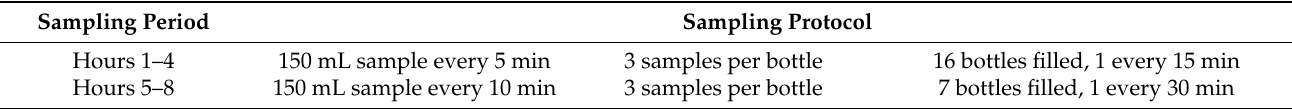
Table 1. Auto-sampler sampling schedule.